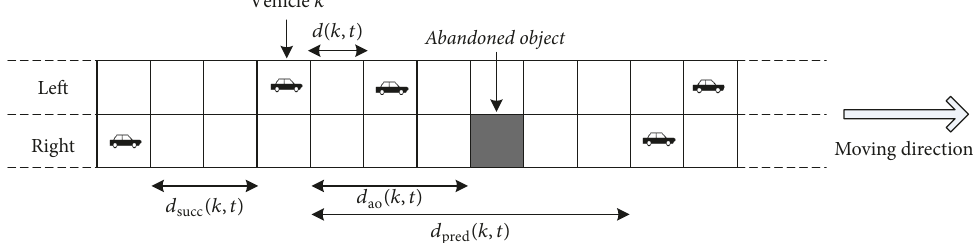
Figure 2: Positions of vehicles and the abandoned object for left lane changing rules in V-ATCA-AO.